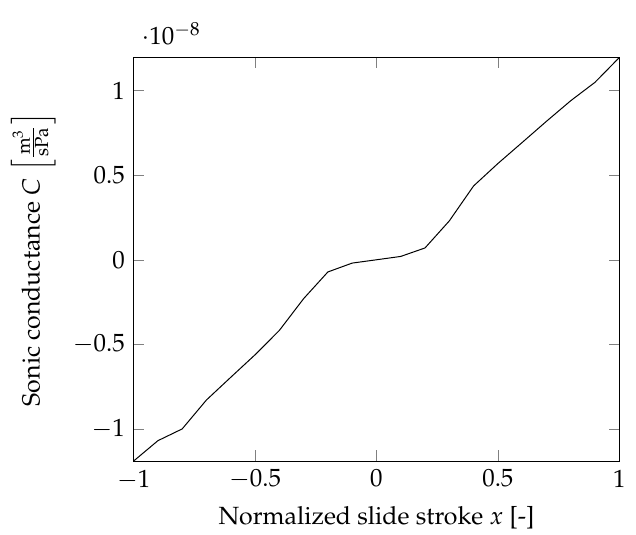
Figure 5. Sonic conductance C in dependency on the normalized valve slide stroke x of a Festo MPYE-5-1/8-LF-010-B proportional servo valve